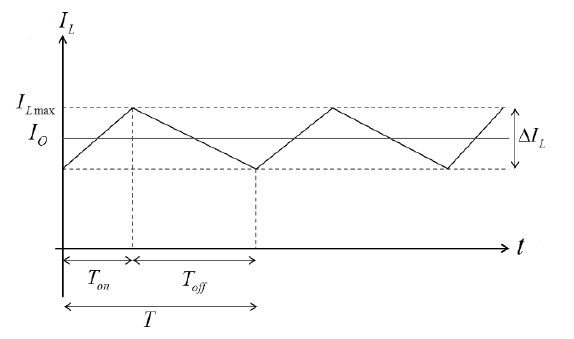
Figure 2. Perturbation of inductor current.